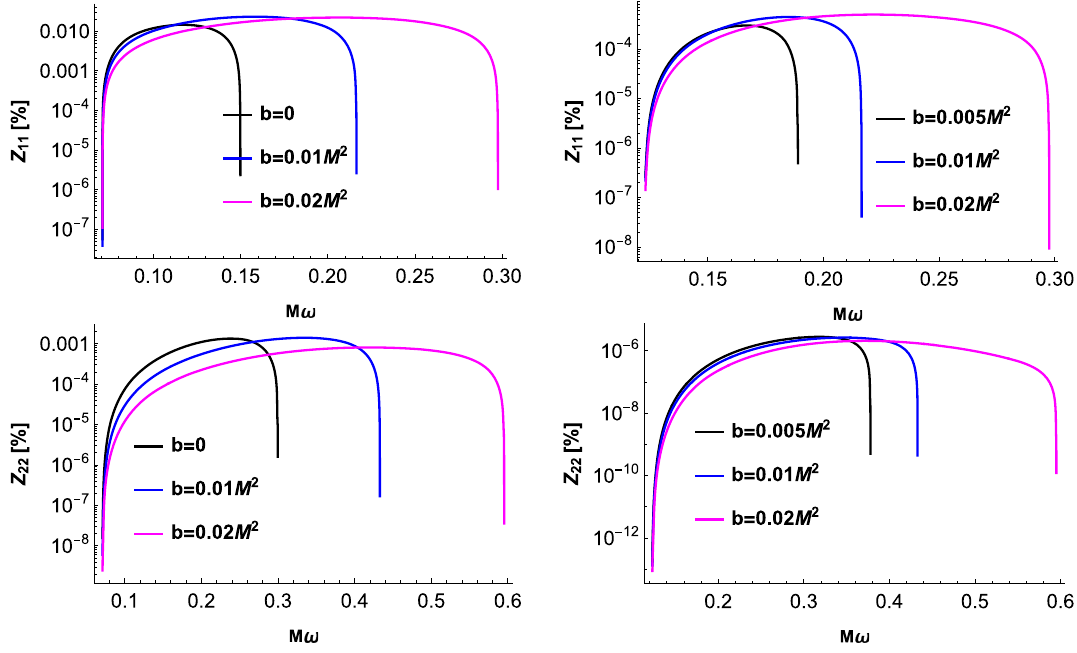
Fig. 8 Variation of amplification factors with b for various multipoles with ˆ μ = 0 . 1 and ˆ a = 0 . 55 M . For left ones (cid:2) = − 0 . 5 and for right ones (cid:2) = 0 .